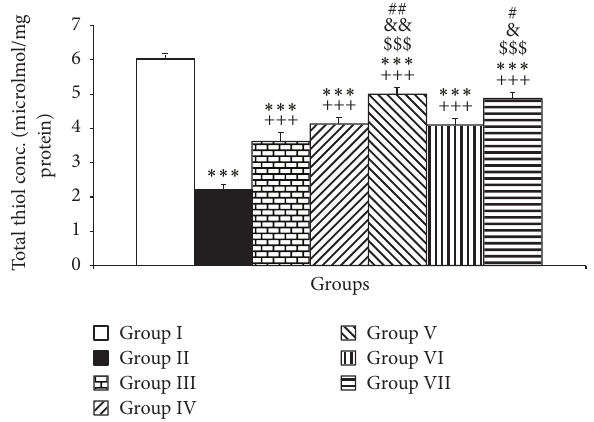
Figure 4: The effects of PTU, Vit E, pioglitazone, and rosiglitazone on cerebellar SOD. Data are presented as mean ± SEM; 𝑛 = 7 . ∗∗∗ 𝑃 < 0.001 versus group I; +++ 𝑃 < 0.001 versus group II; $$ 𝑃 < 0.01 and $$$ 𝑃 < 0.001 versus group III and && 𝑃 < 0.01 compared to group IV; ## 𝑃 < 0.01 and ### 𝑃 < 0.001 compared to VI.